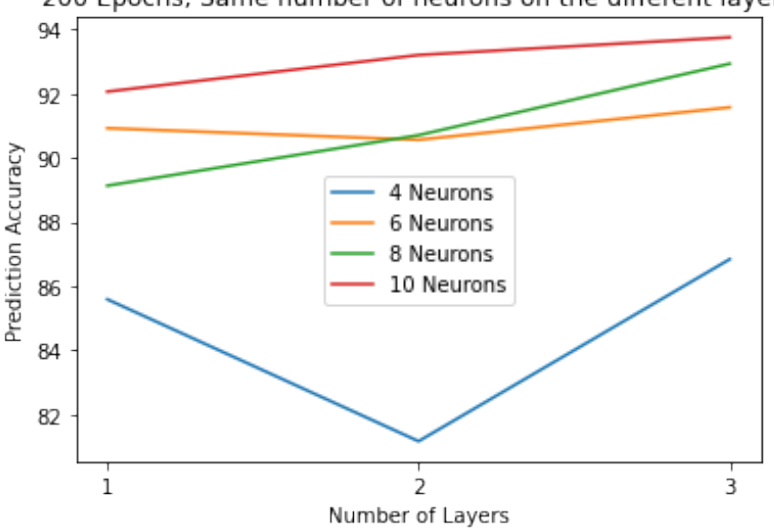
Figure 8. The effect of adding further hidden Layers on the ANN prediction accuracy (%). The ANN model with three hidden layers each having 10 neurons was chosen as the optimal model for predicting the droplet categories. The evolution of the accuracy and loss over the training are shown in Figures 9 and 10, respectively.